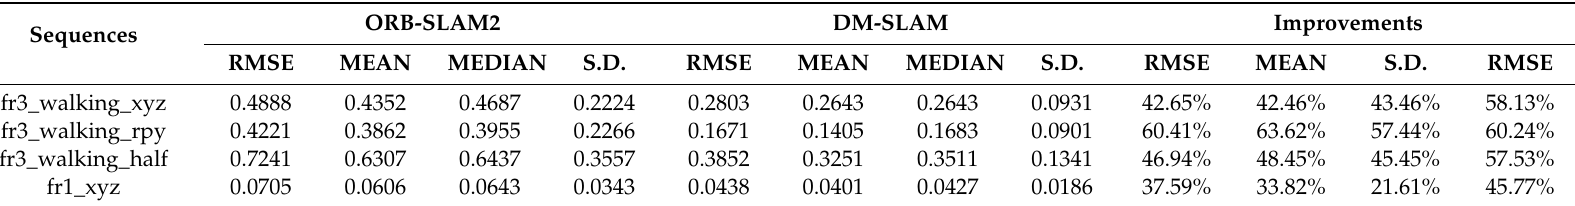
Table 3. Results of metric translational drift (RTE).